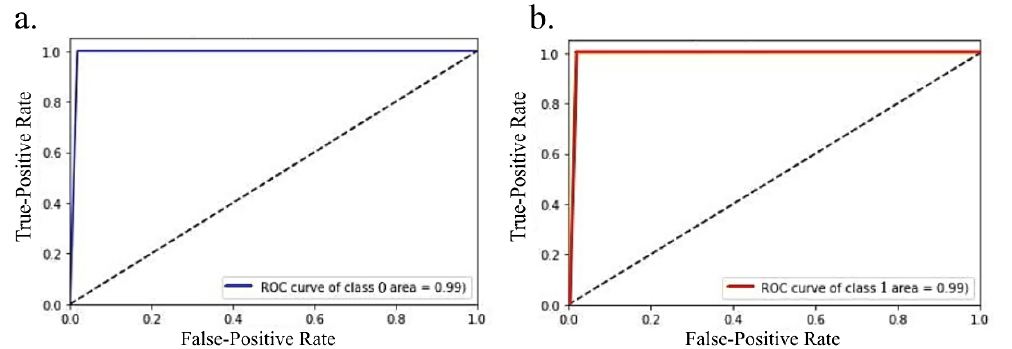
Figure 4. Receiver operating characteristics of the deep learning model where connectivity matrix was considered as a matrix for LGG (shown in a ) and HGG (shown in b ), the area under curve (AUC) score for both classes were 0.99. The above plot was obtained using Python sklearn package. Table 3. The confusion matrix for the DNN model where the connectivity matrix was used as a matrix. A total of 110 test images were used.